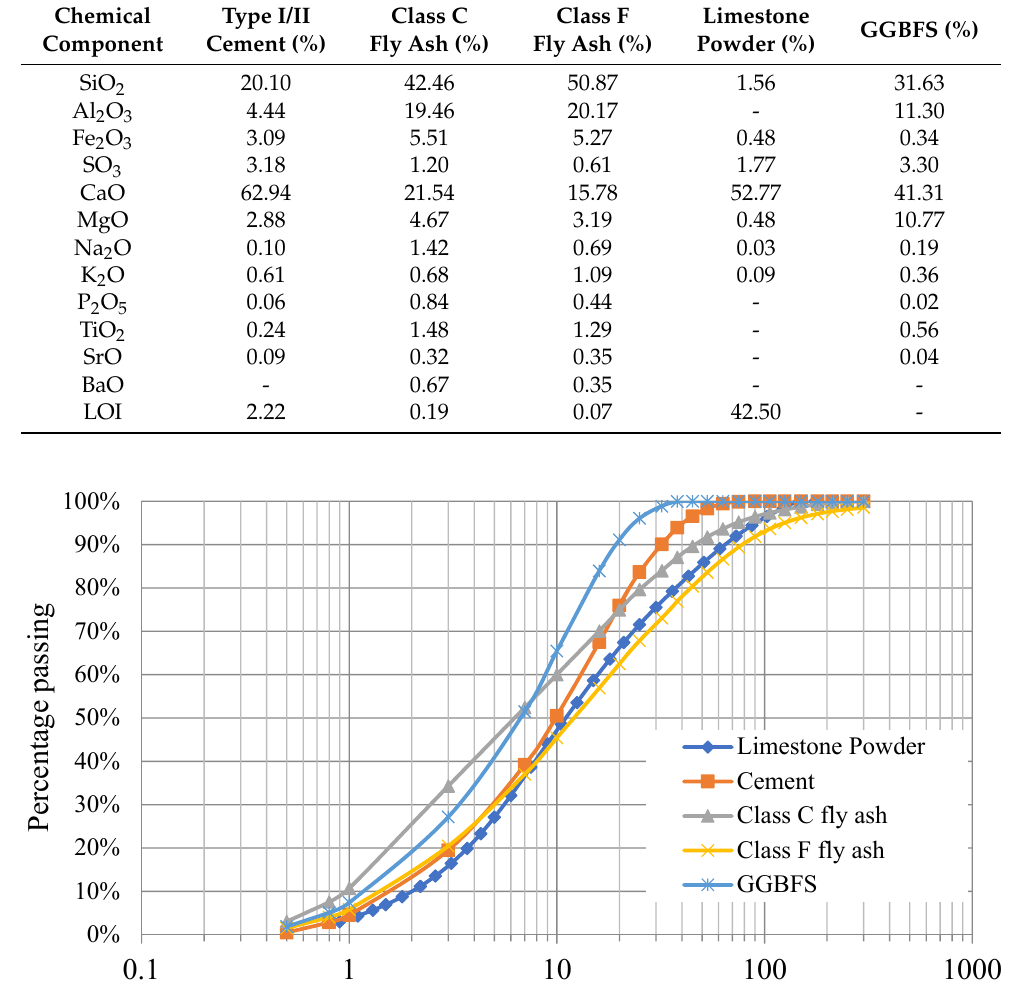
N/A Figure 2. Particle size distribution of fine and coarse aggregates (25 mm = 1 in.).